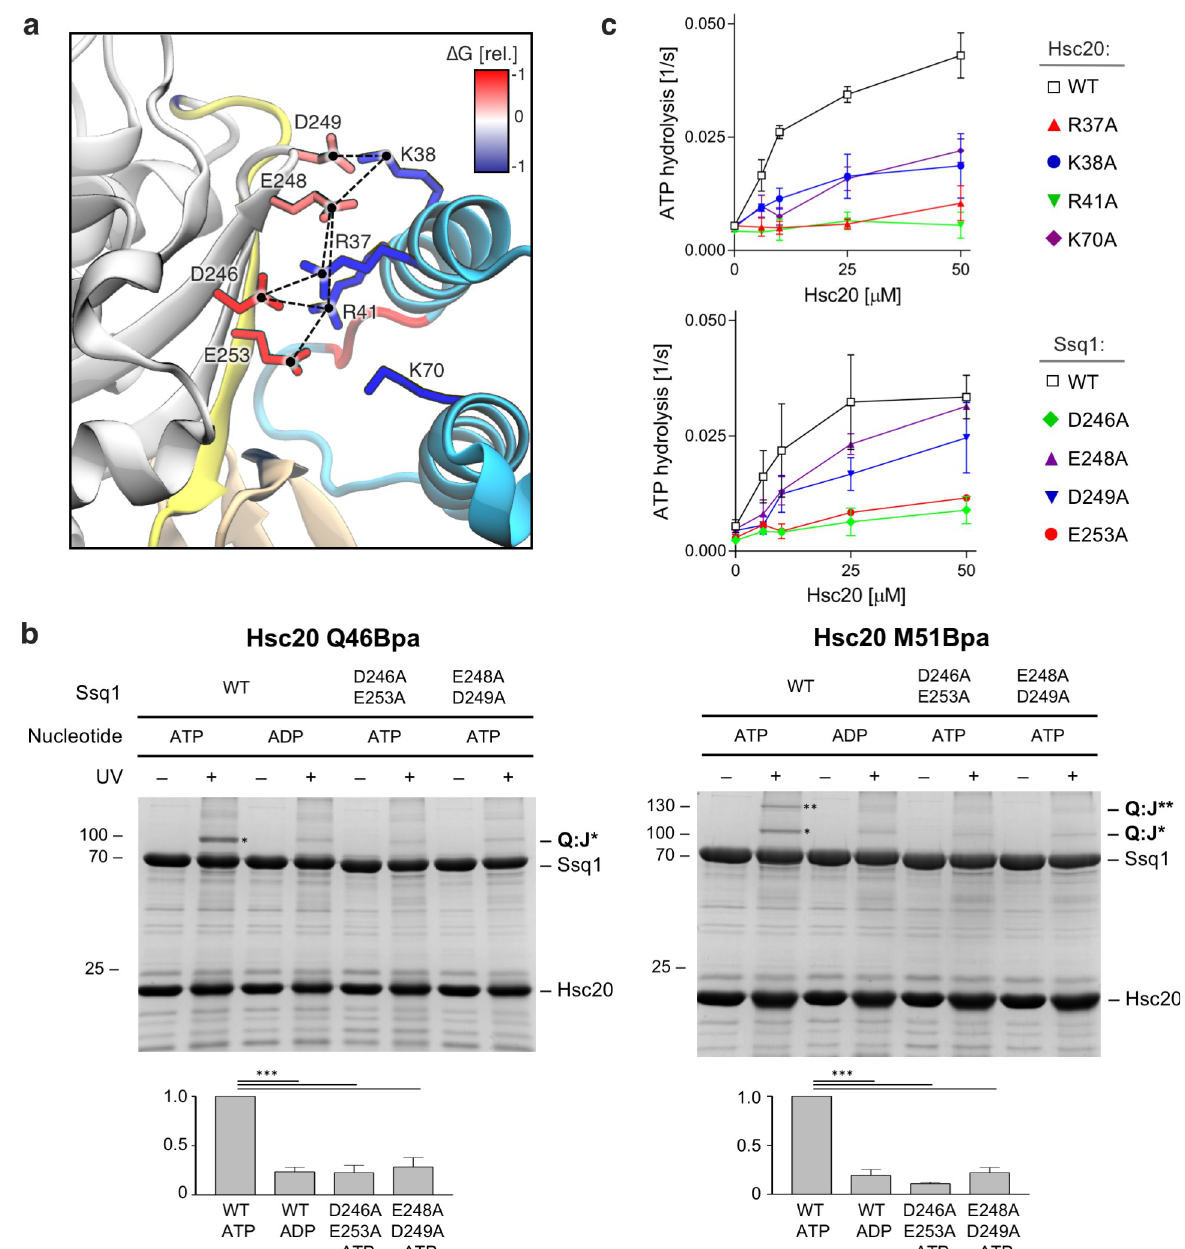
Fig 4. Electrostatic interface of Hsc20 J-domain and Ssq1. (a) Network of key polar interactions at the binding interface between the J-domain of Hsc20 (cyan) and Ssq1 subdomain IIa (grey), linker (yellow) and SBD β (brown). The most stable ion pairs and hydrogen bonds identified in MD simulations are indicated with dashed lines. Relative contributions of individual residues to the Hsc20-Ssq1 complex stability are indicated by color scale; blue for J-domain residues and red for Ssq1 residues. Note: K70 JD does not form obvious contacts but contributes strongly to the complex stability. (b) Site specific crosslinking of Hsc20 to Ssq1. Purified Hsc20 Q46Bpa (left) and M51Bpa (right) variants were incubated with purified Ssq1 wild-type (WT) or alanine substitution variants (D246A, E253A or E248A, D249A) in the presence of ATP. After UV irradiation (+), or as a control no irradiation (-), reaction mixtures were separated by SDS-PAGE. Migrations of size standard, in kDa, are indicated; Q:J � and Q: J �� indicate positions of the Ssq1-Hsc20 crosslinks, which were identified using mass-spectroscopy (S9 Fig); we do not understand the nature of the more slowly migrating crosslink band (Q:J �� ) present in the M51Bpa variant sample. Quantification of three independent Bpa crosslinking experiments; statistically significant differences (t-student test, p < 0.001) are indicated ( ��� ). (c) Stimulation of Ssq1 ATPase activity by Hsc20 was measured in the presence of 0.5 μ M of Ssq1, 500 μ M of PVK-peptide substrate, 0.5 μ M of nucleotide exchange factor Mge1 and indicated concentrations of Hsc20. (top) Hsc20 WT and alanine substitution variants. (bottom) Ssq1 WT and alanine substitution variants. Error bars indicate standard deviation for three independent